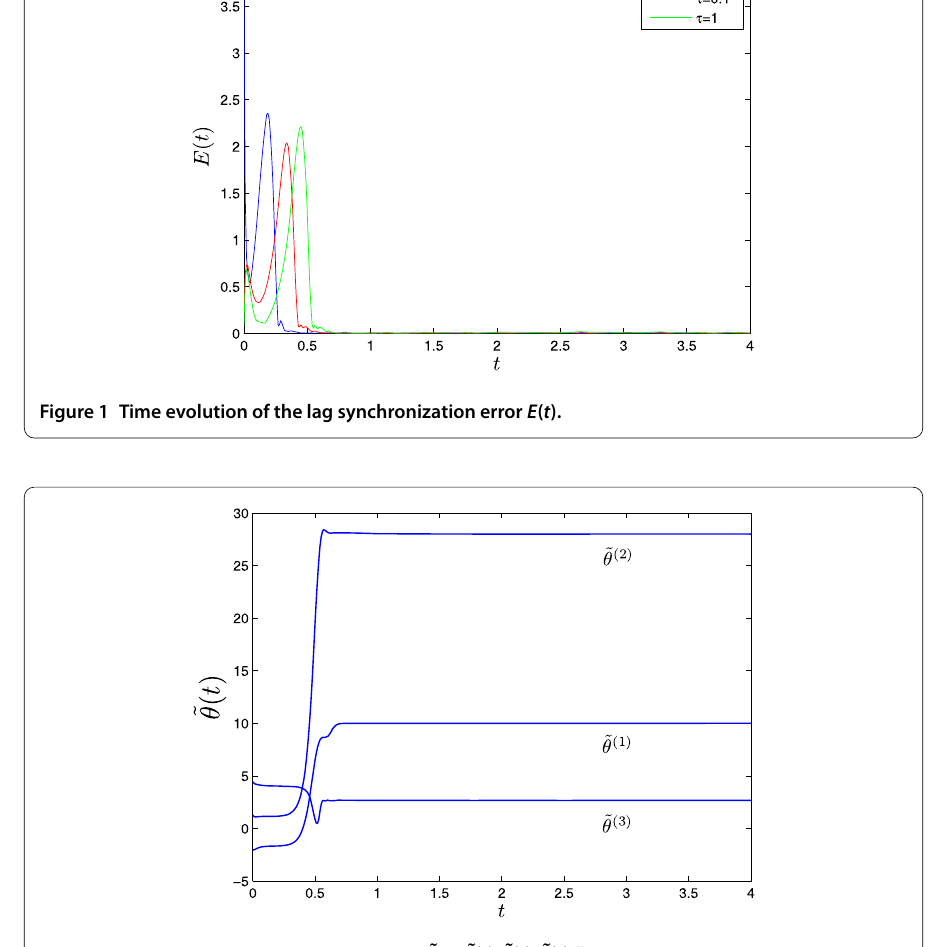
Figure 2 The estimated unknown parameter τ =